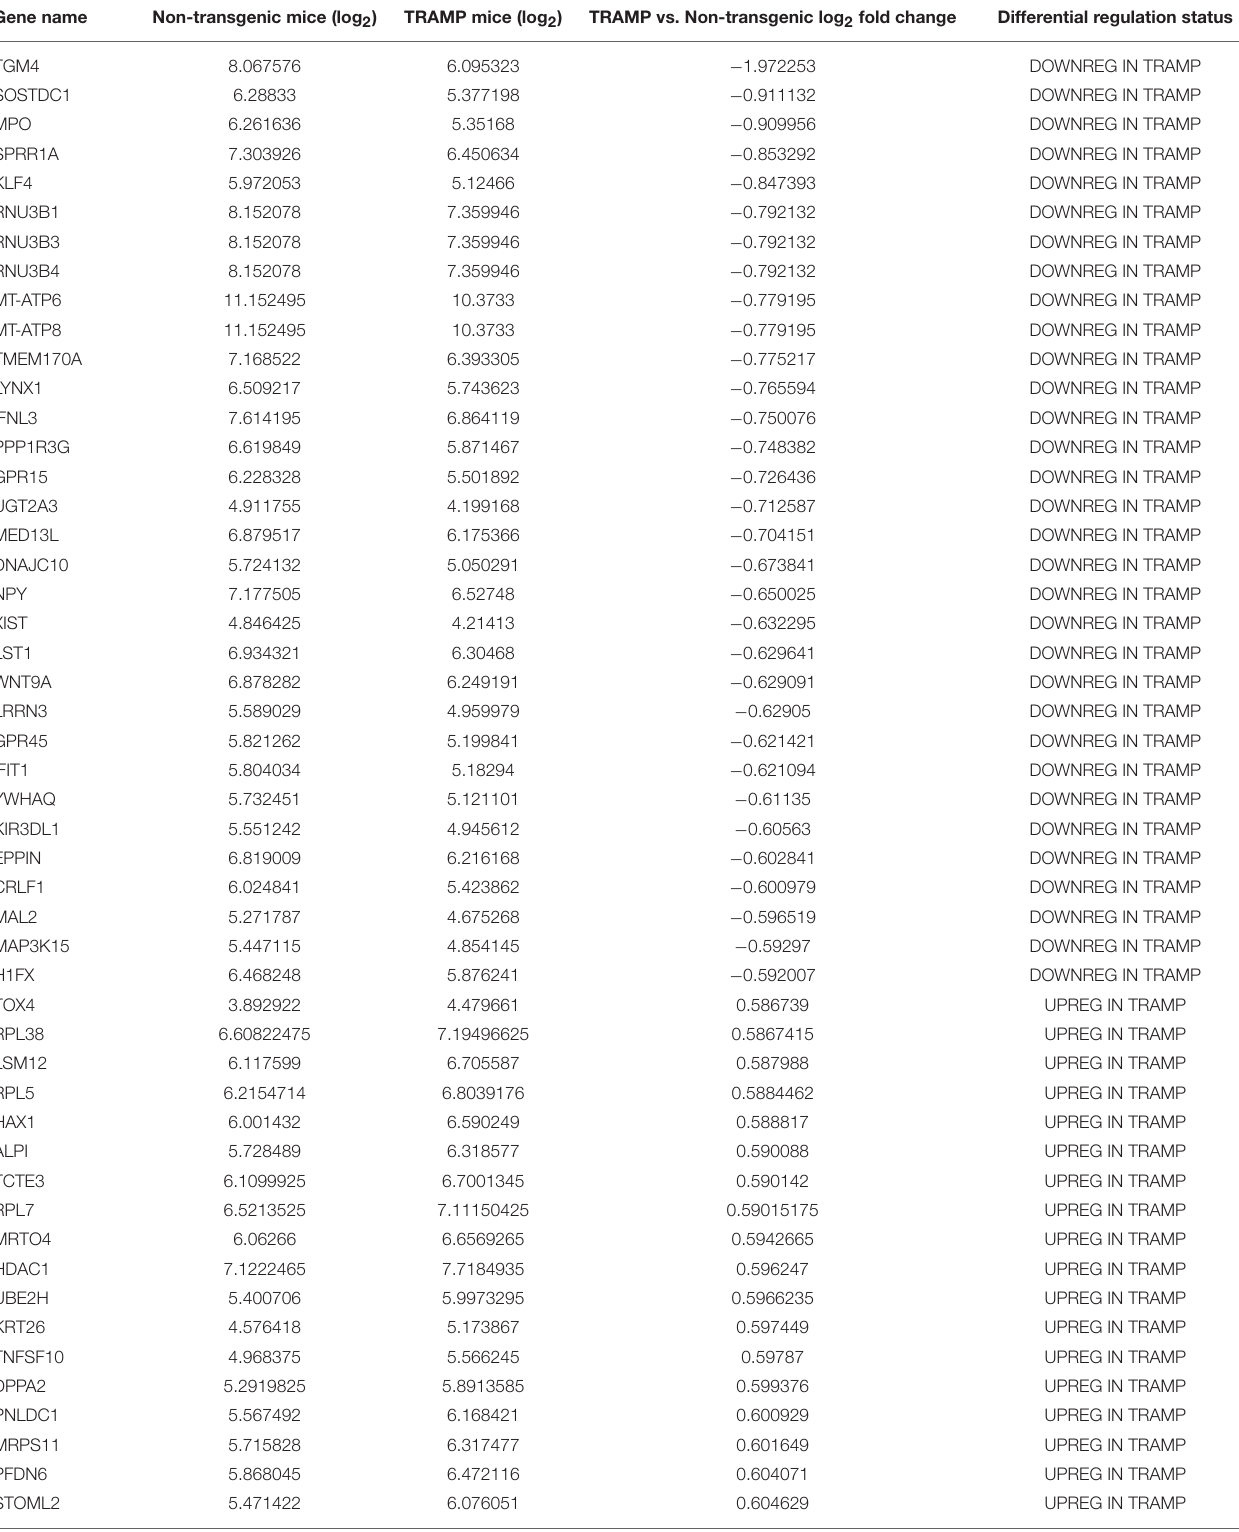
TABLE 1 | Detailed list of gene sets significantly enriched in microarray gene